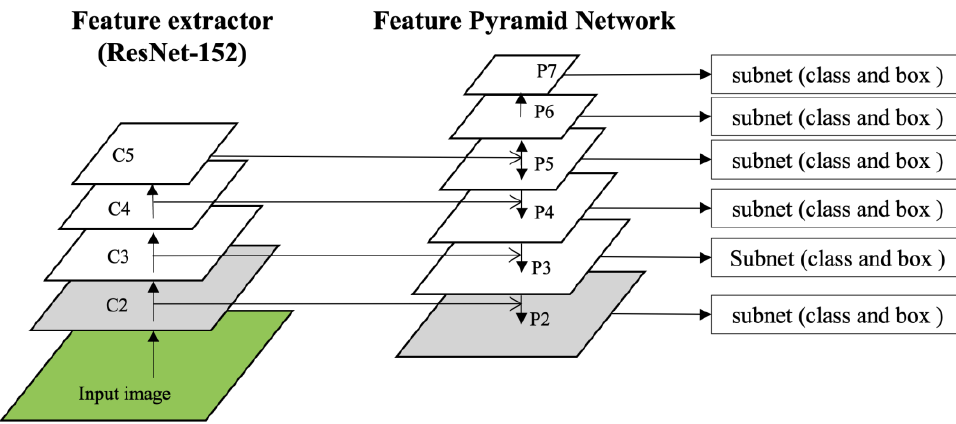
Figure 4. The structure of the improved neural network for small lesion detection.